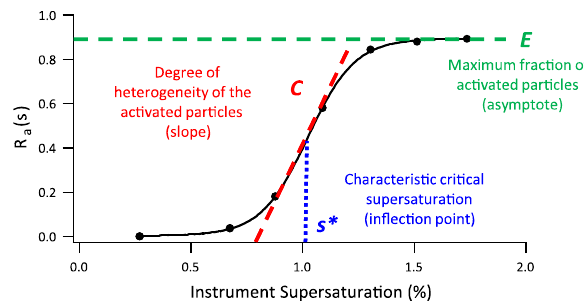
Fig. 3. Example of an activation spectra and fitted